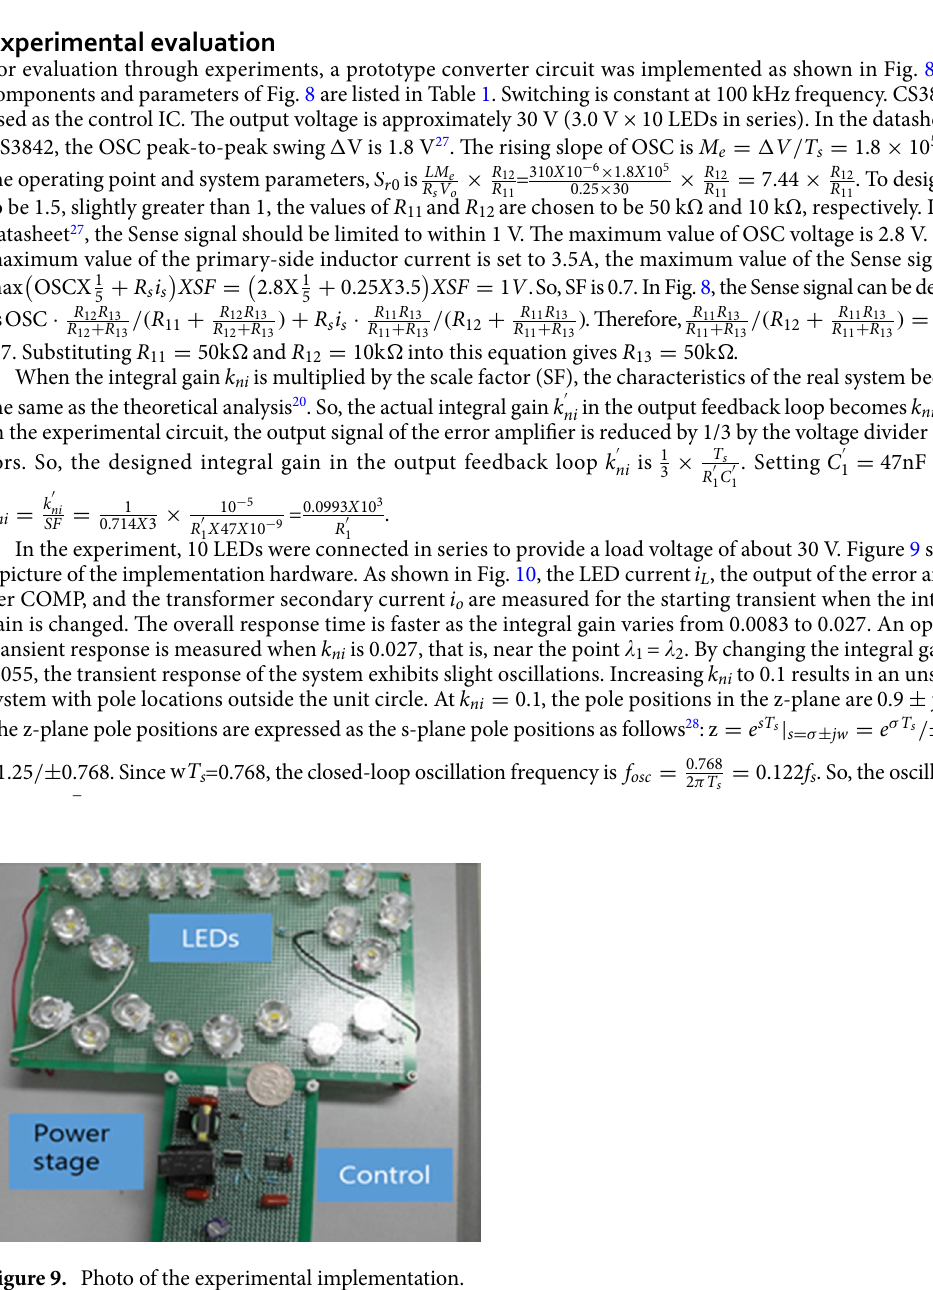
Figure 9. Photo of the experimental